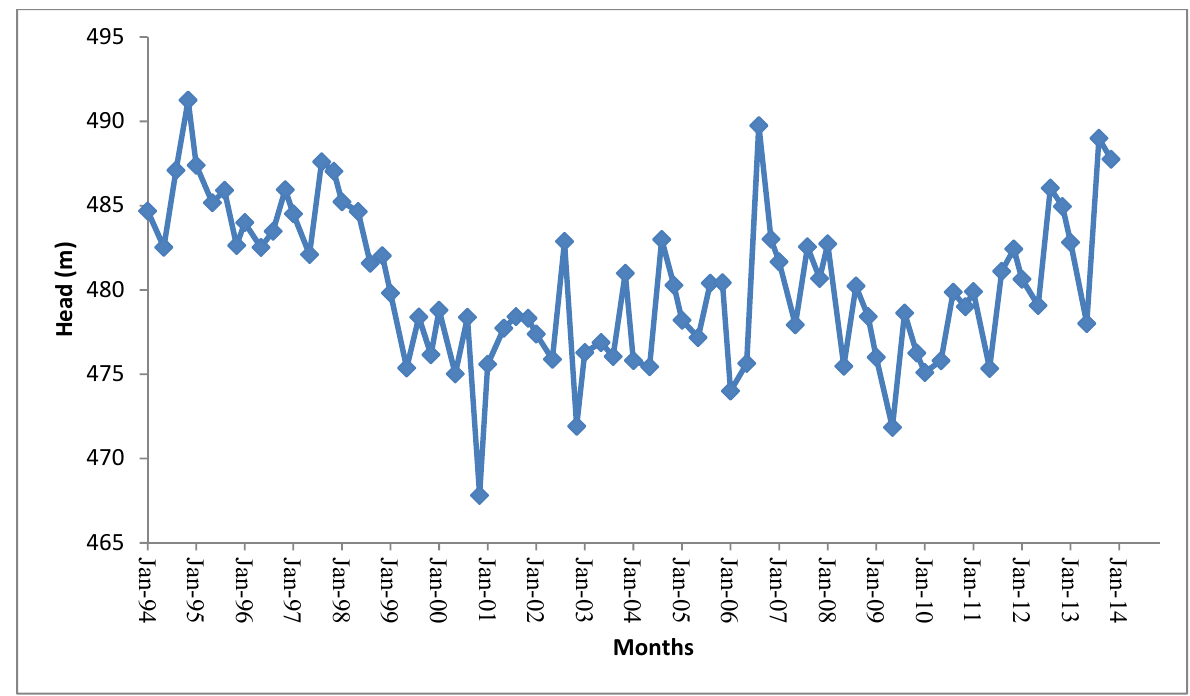
Figure 5. Central Ground Water Board groundwater head trends for the Dharta watershed from January 1994 to November 2013.